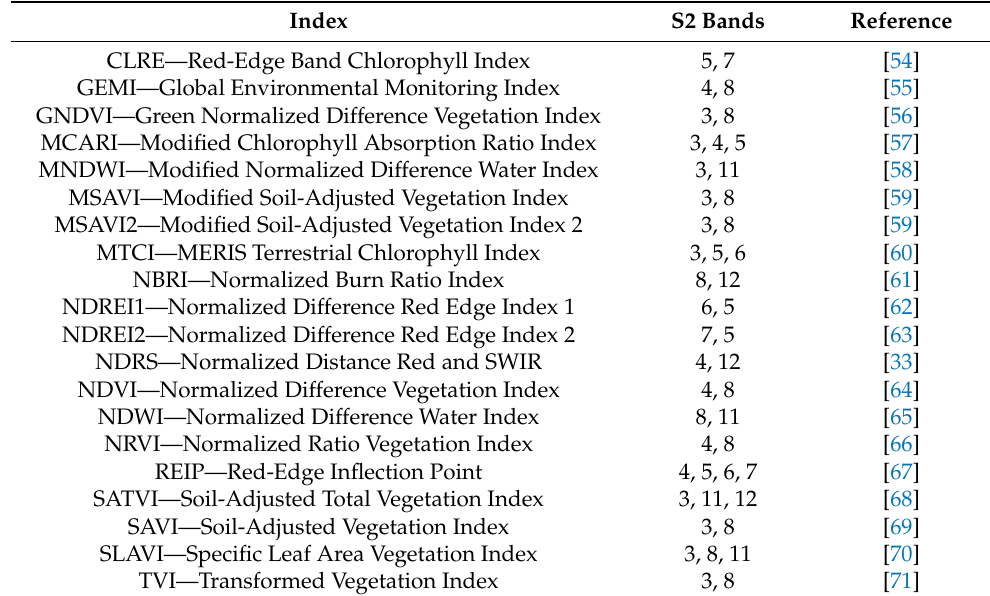
Table 2. Vegetation indices extracted from each S2